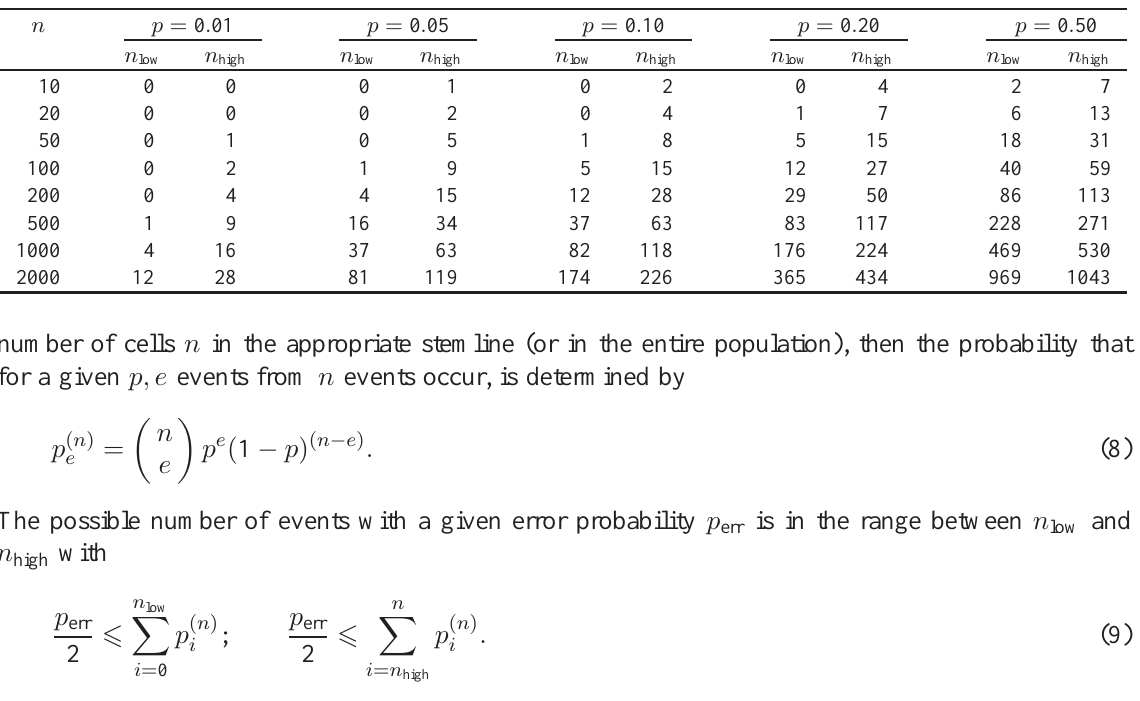
Fig. 7. DNA histograms of the reference cells (left) and the analysis cells (right) of a hypotetraploid breast cancer. Beside a diploid peak an aneuploid stemline is detected at 3.74 c with p = 0 . 00003 (peak no. 2). Table 4 95% confidence regions of the same probability of occurence for e events in increasing numbers of n events. In n trials an event occurs with the probability of occurence p between the lower ( n low ) and upper ( n high )